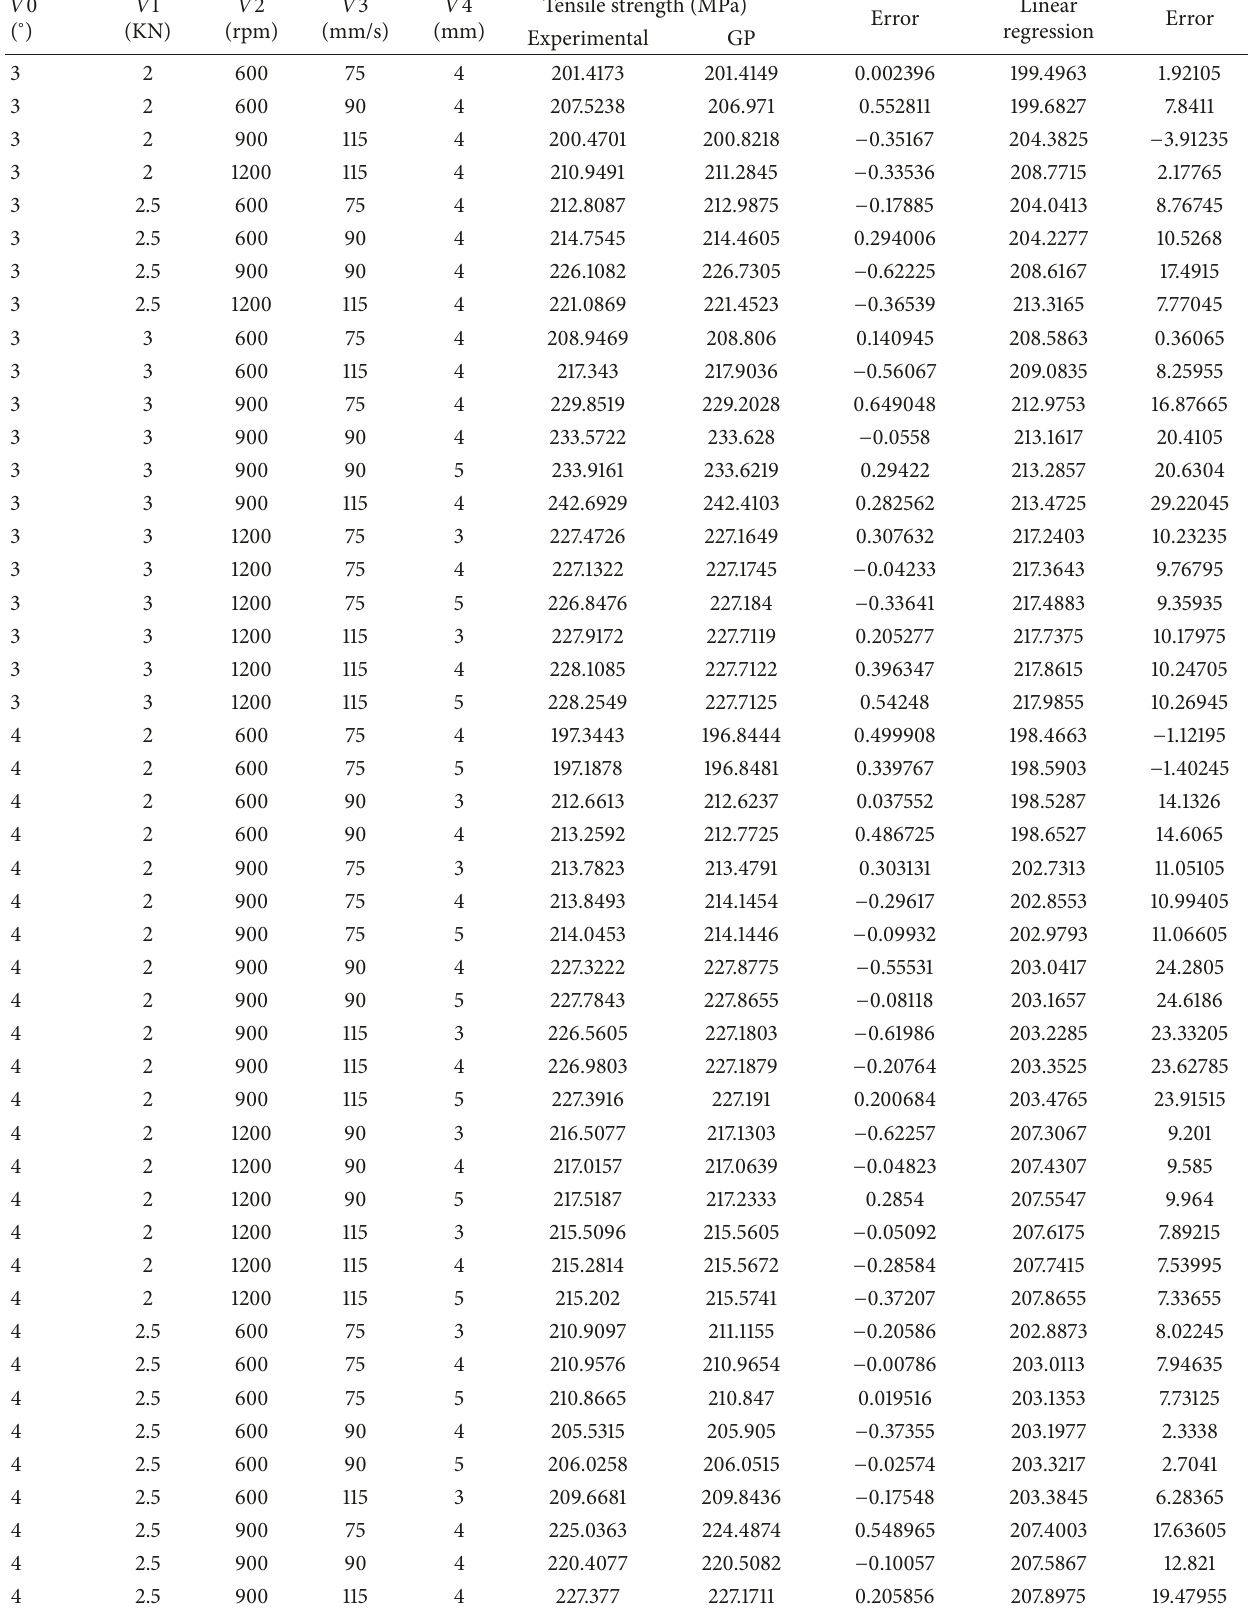
Table 4: Comparison between experimental and predicted values of tensile strength at R 2 = 99.5%